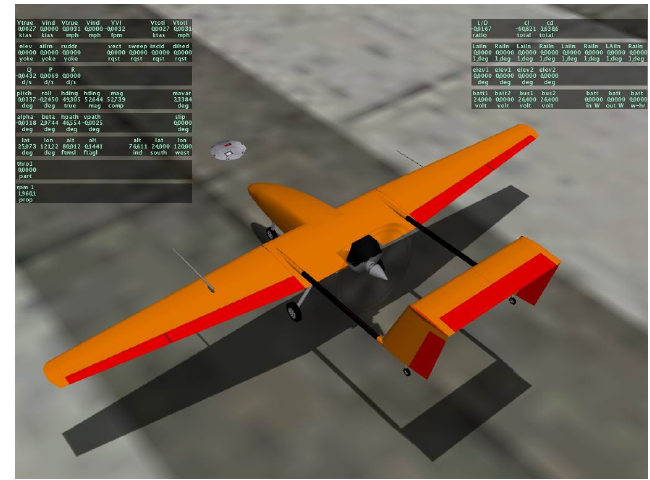
Figure 10. Spoonbill unmanned aerial vehicle (UAV) in X ‐ Plane flight simulator.